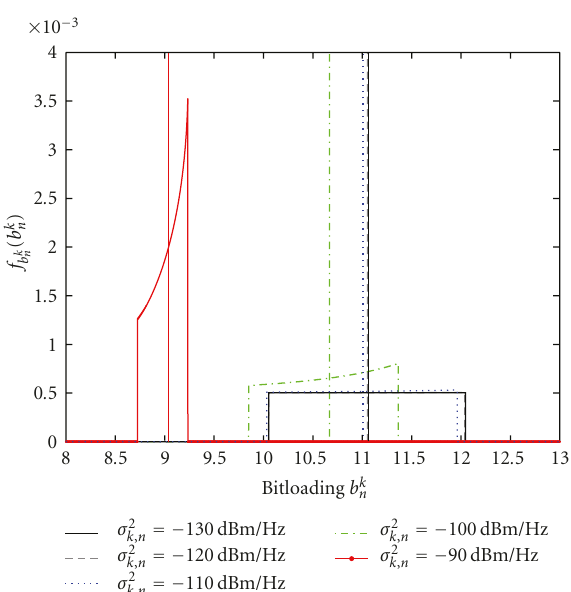
Figure 4: The PDF f ( b k ) for a tone k = 300 and for di ff erent n b k n background noise σ 2 levels. The bitloading calculated with (2), k , n corresponding to error-free estimation ( (cid:14) Δ = 1), is represented by the vertical lines.